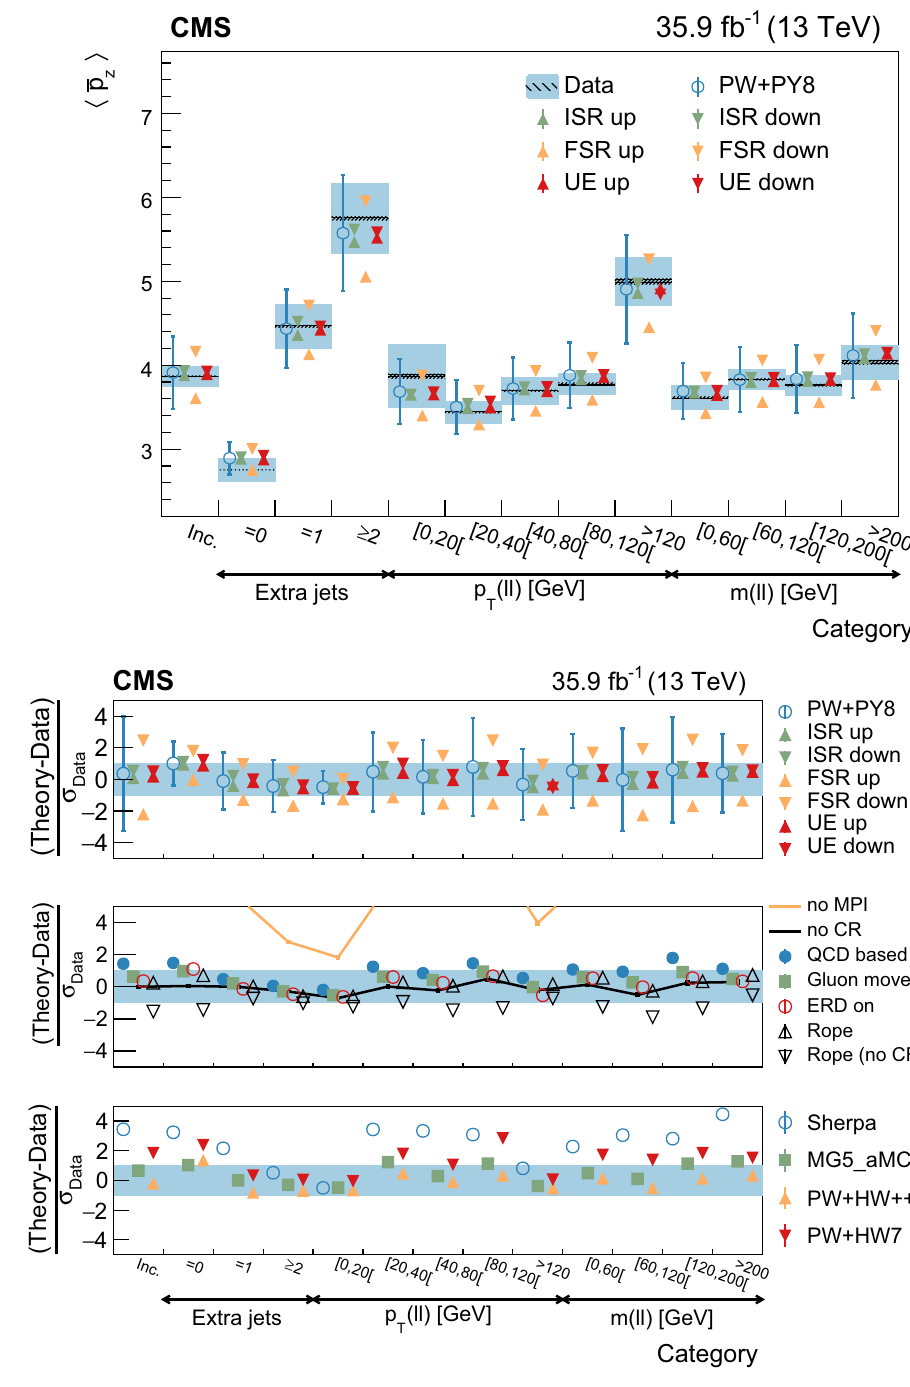
Fig. 18 Average p z in different categories. The conventions of Fig. 14 are